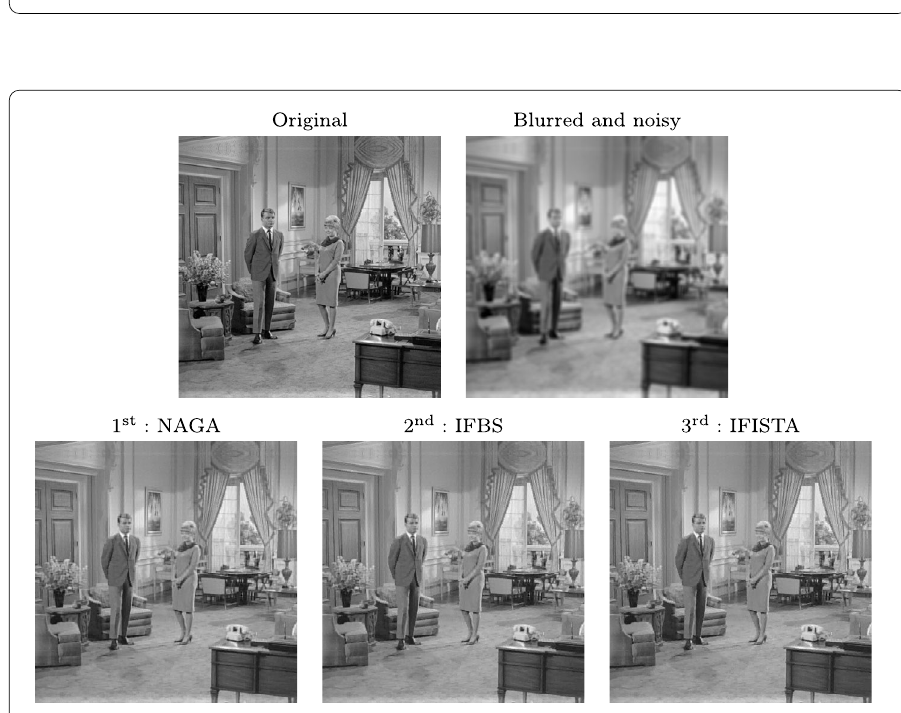
Figure 12 Top three fast convergence with good performance for deblurring of Living room